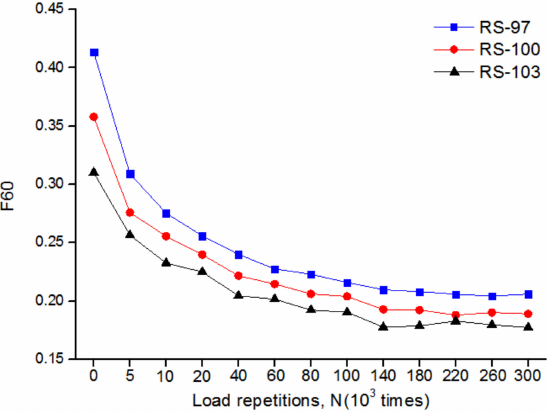
Figure 13. Changes of friction parameter ( F 60 ) with load